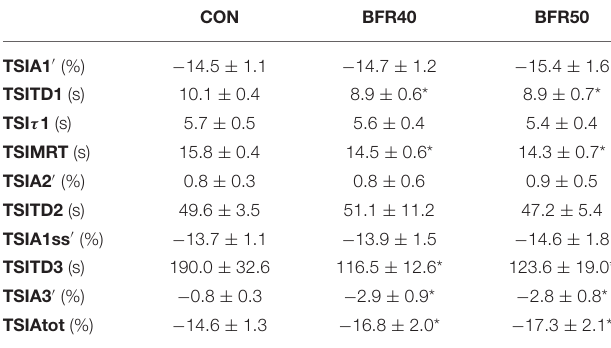
TABLE 2 | Oxygen extraction kinetics parameters for exercise without blood flow restriction (CON), with 40% (BFR40) or 50% (BFR50)